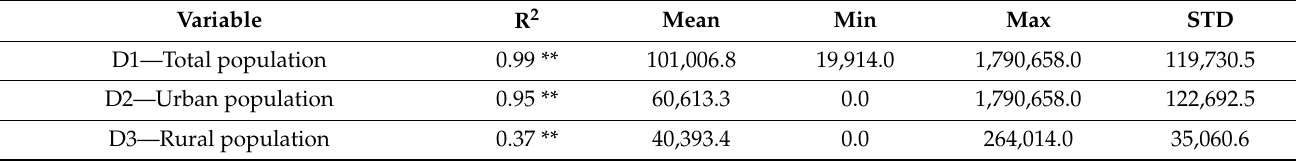
Table 3. R 2 and statistical description of the variables. Source: own elaboration on the basis of ArcGIS Pro 2.9 by